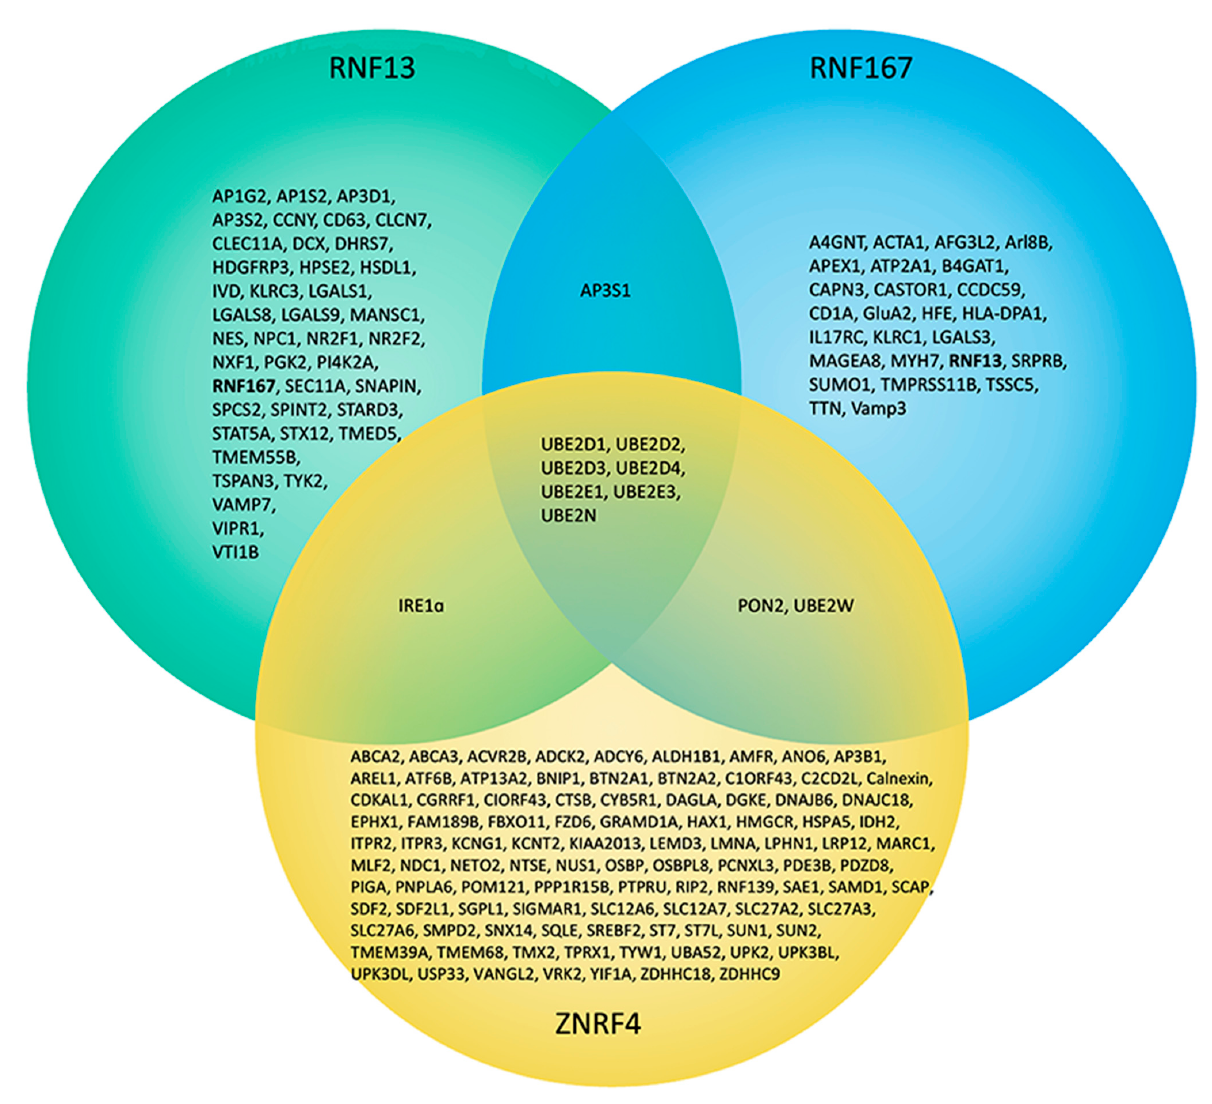
Figure 3. Venn diagram comparing the interactors of RNF13, RNF167, and ZNRF4. Interactors of RNF13 (green), RNF167 (blue), and ZNRF4 (yellow) discovered by both low and high throughput assays are displayed